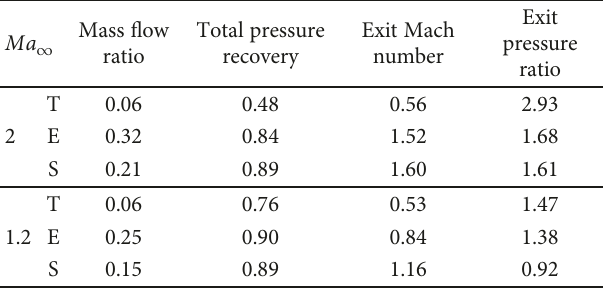
Table 4: Mass-averaged performance of the tri-duct inlet at Ma and